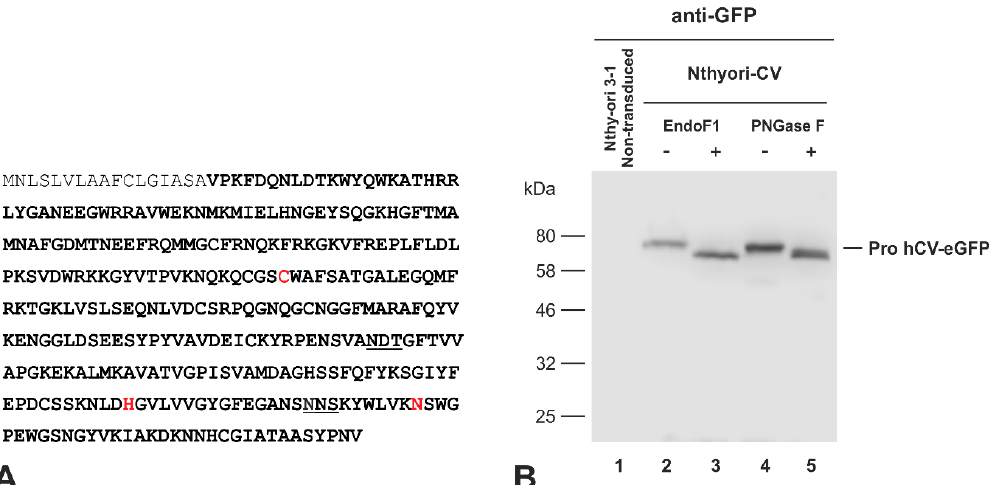
Figure 3. N-glycosylation state of hCV-eGFP chimeric protein in thyroid epithelial cell lines. ( A ) The amino acid sequence of human cathepsin V (UniProt accession number O60911) contains two potential N-glycosylation sites of the motif “N-X-S/T-NOT P” at positions Asn-221 and Asn-292 (underlined). The active site residues Cys-138, His-277 and Asn-301 indicative of cysteine peptidases are highlighted in red. The propeptide is indicated in gray font. ( B ) Immunoblots of lysates prepared from Nthy-ori 3-1 control (lane 1) or Nthyori-CV cells, treated without (lanes 2 and 4) or with (lanes 3 and 5) EndoF1 or PNGase F, were probed with anti-GFP antibodies. Molecular mass markers are indicated in the left margin. Faster migration due to glycosidase-mediated reduction in the molecular mass of the proform of hCV-eGFP chimeras was indicative of the removal of N-linked glycans. 2.4. The Transport Route of the Chimeric Protein hCV-eGFP in Thyroid Epithelial Cells To analyze trafficking and sorting of eGFP-tagged full-length cathepsin V in more detail, Nthyori-CV cells were immunostained with compartment-specific markers, namely, by using antibodies against the ER-resident protein disulfide isomerase (PDI), the cis-Golgi matrix protein GM130, and the lysosome-associated membrane protein 1 (Lamp1). The results revealed co-localization of hCV-eGFP chimeric protein with PDI in ER-like reticular distribution patterns (Figure 4A, yellow signals). In addition, eGFP-tagged full-length cathepsin V was observed in PDI- negative cisterna-like structures in the peri-nuclear region (Figure 4A, asterisk, green signals) which were identified as belonging to the Golgi apparatus by the pronounced co-localization with GM130 (Figure 4B, yellow signals). The chimeric hCV-eGFP protein was also found to co-localize with Lamp1-positive vesicles in Nthyori-CV cells but only in some endo-lysosomes (Figure 4C, yellow signals). The results demonstrated that the hCV-eGFP chimeric protein is synthesized at the ER and targeted for entry into its lumen before being transported to the Golgi apparatus and delivery to its final destination, the endo-lysosomal compartments. Co-localization of hCV-eGFP with markers of early secretory pathway compartments was notably more extensive than with endo-lysosomal markers.